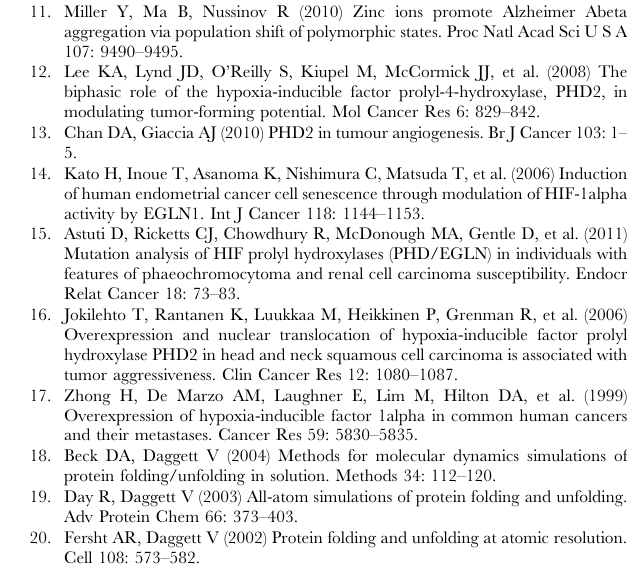
Figure S1 The interaction energy between Fe ion and histidine residue 374 is indicated. Figure S2 The interaction energy between Fe ion and acidic residues is indicated. Figure S3 It is a scheme of Fe detaching consequence. Fe atom is pushed out from active site lumen of fh-PHD2 without rupturing active site floor. In f-PHD2, Fe ion tries to escape from active site while D315 traps Fe so it rupture active site floor. Figure S4 The animated GIF file shows the fate of Fe atom upon f-PHD2 unfolding. The Fe atom is mentioned by yellow sphere. The red surface represents active site lumen.